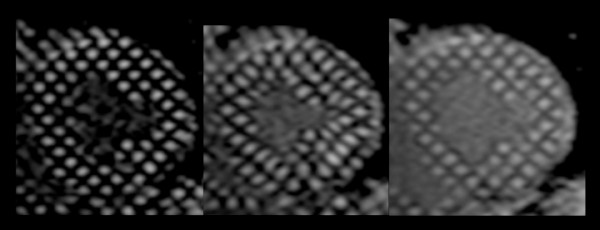
71-year-old man with triple-vessel disease. Short-axis mid-ventricular views of tagged cine CMR images (left: first frame at end-diastole; center: end-systole; right: last frame at end-diastole). The tagging grid persists throughout the cardiac phase on cine imaging.